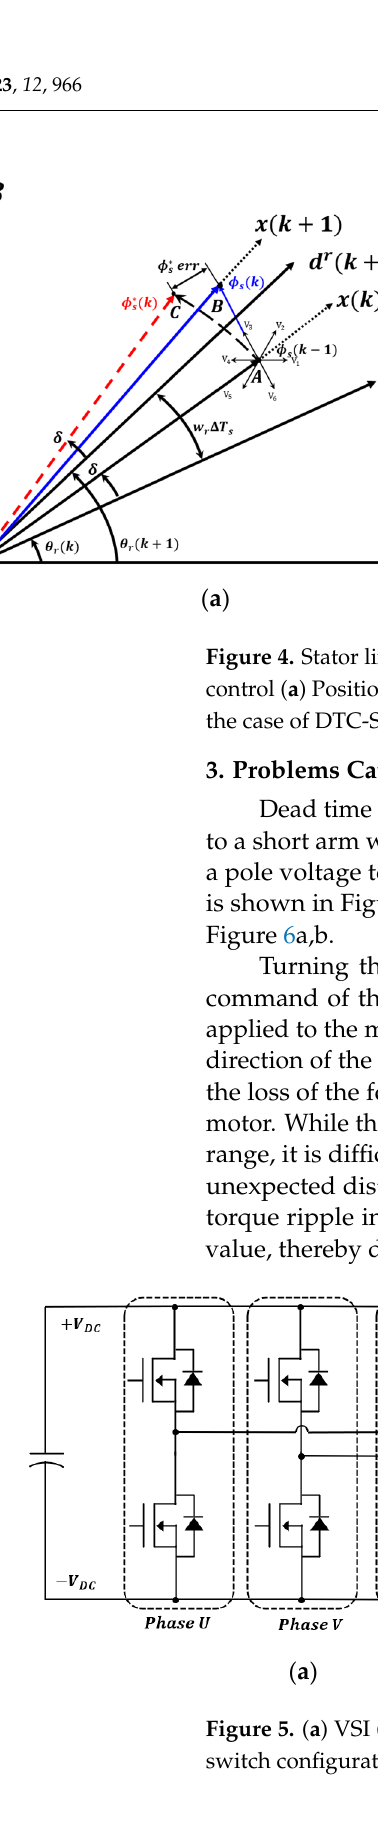
( b ) Figure 6. ( a ) ON/OFF signal of TOP/BOTTOM power switch element in an ideal case without dead time. ( b ) ON/OFF signal of TOP/BOTTOM power switch element with dead time. Turning the switch on or off during each phase applies the pole voltage output com- mand of the controller to the motor. In the dead time, unexpected pole voltage is applied to the motor by conducting the diode of the power switch device according to the direc- tion of the current. This is shown in Figure 7. Additionally, when the diode conducts, the loss of the forward voltage, which the diode itself has, is reflected and applied to the mo- tor. While this is relatively small in size and can be ignored in the high-speed operation range, it is difficult to ignore in the low-speed range. In addition, the application of such unexpected disturbance voltage eventually causes a distortion of the phase current and torque ripple in the DTC-SVM algorithm, which estimates stator flux using the current value, thereby degrading performance.